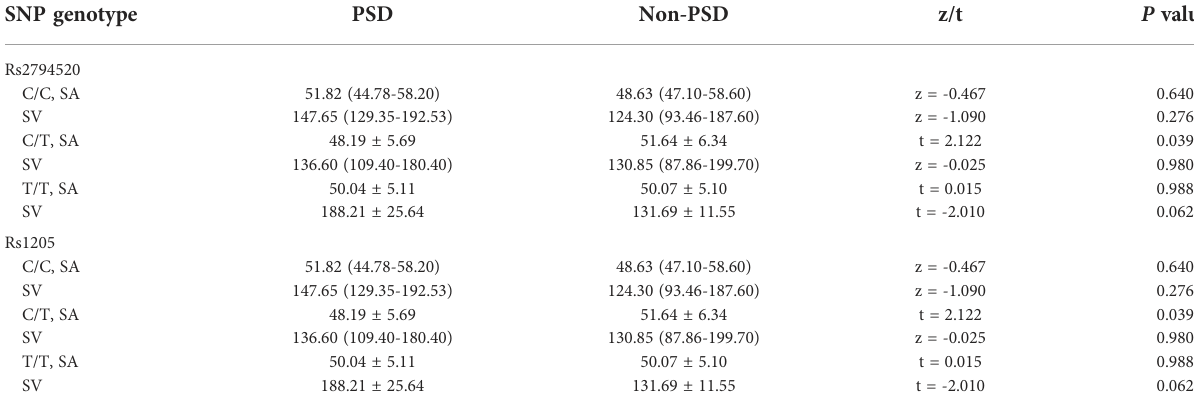
TABLE 3 SA and SV by CRP SNP genotypes and PSD